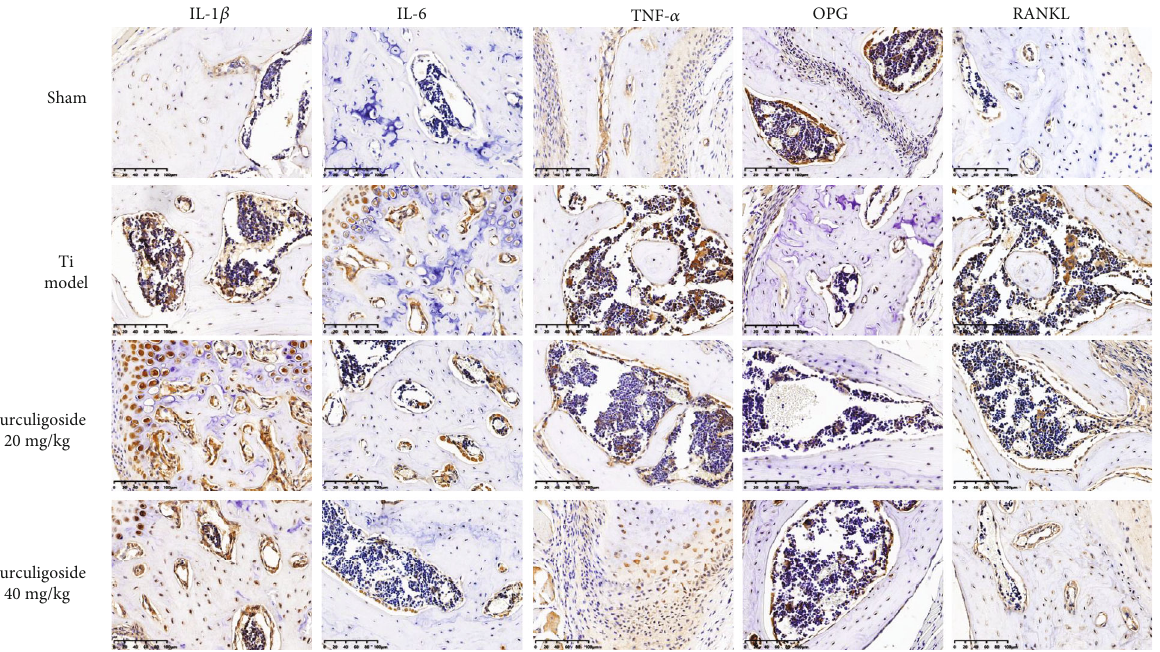
Figure 9: Immunohistochemical analysis for RANKL, OPG, TNF- α , IL-1 β , and IL-6 in calvaria sections of each group of mice. Ti: titanium particle. Magni fi cation, ×